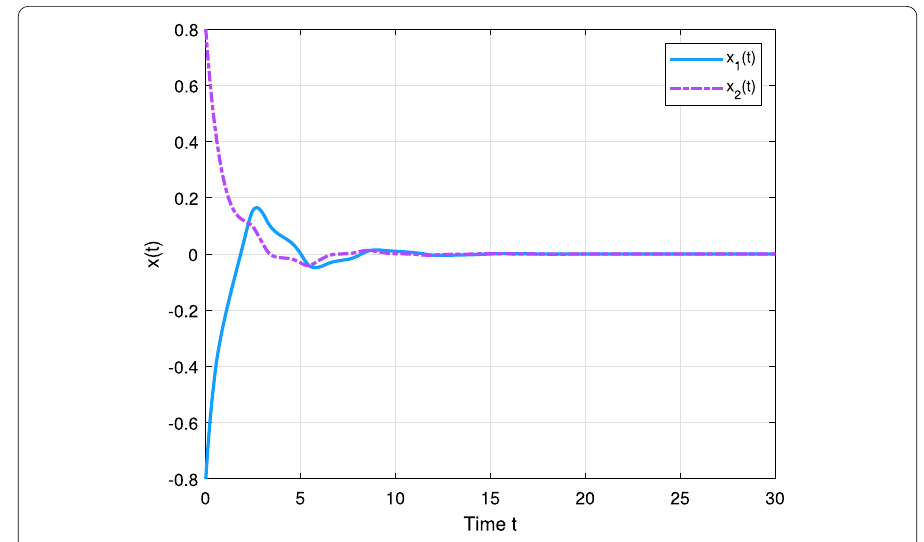
Figure 4 State responses of x ( t ) for the GNNs (35) in Example 4.2